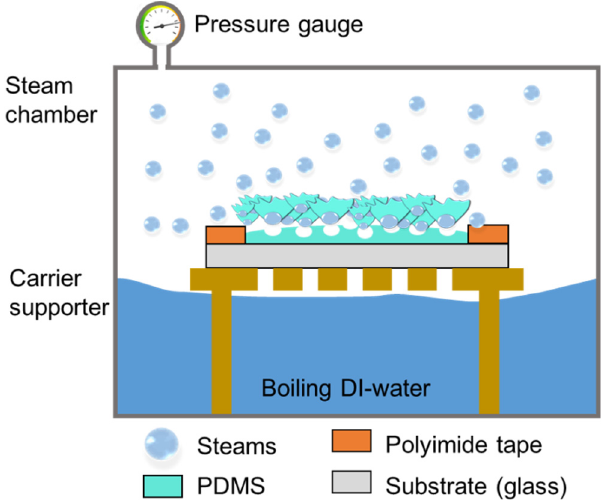
Figure 7. Schematic of mechanism of the formation of porous structure from uncured PDMS solution through high-pressure vapor process.